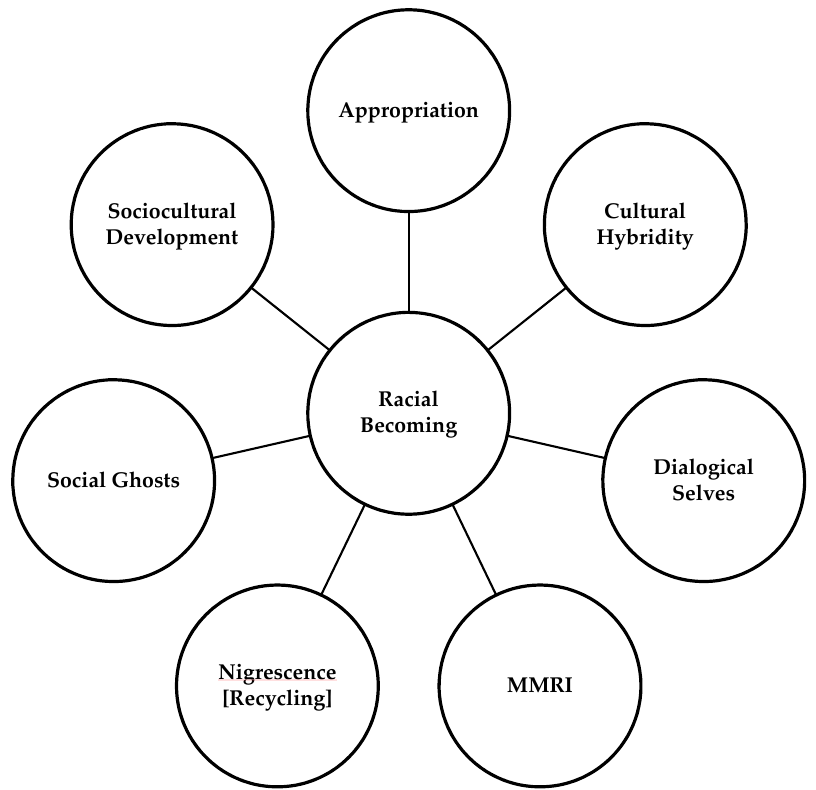
Figure 1. Theories that contribute to racial becoming.